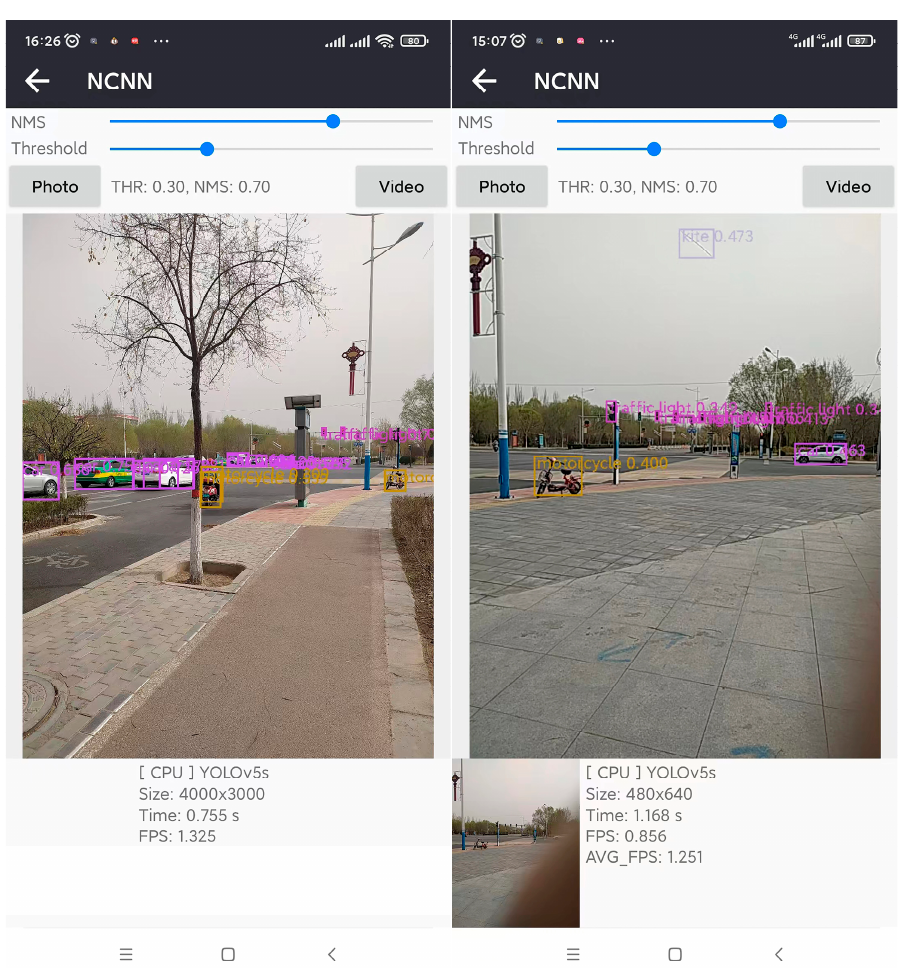
Figure 8. Detection and recognition effect of mobile objects.